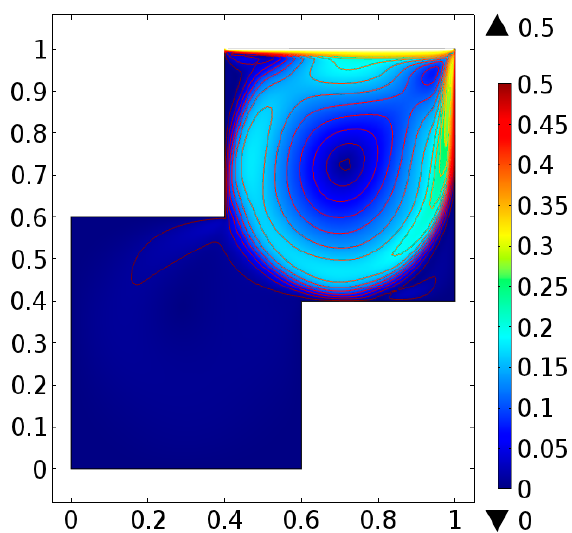
Figure 14. Velocity distribution at Re = 1000 for case-I.